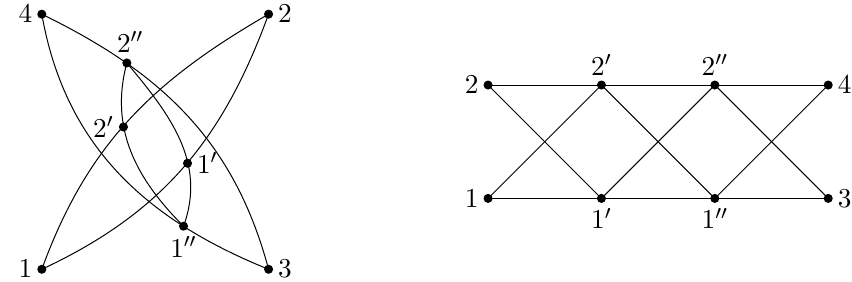
Figure 21. On the left, an embedding of the anomalous dimension diagram from figure 17(a) inside the four-point correlator h φ 2 φ 2 φ 2 φ 2 i . We imagine φ 2 ( x 1 ) φ 2 ( x 2 ) creating the detector L [ φ 2 ] L [ φ 2 ] via the mechanism in figure 18. This detector is measured by particles that propagate from x 3 , x 4 , split at x 00 and x 00 , and are finally detected at x 0 and x 0 . On the right, we re-draw the same diagram in 1 2 1 2 a simpler way that makes clear that it is the cube of the kernel S , which is one of the terms inside S 2 G tree in equation